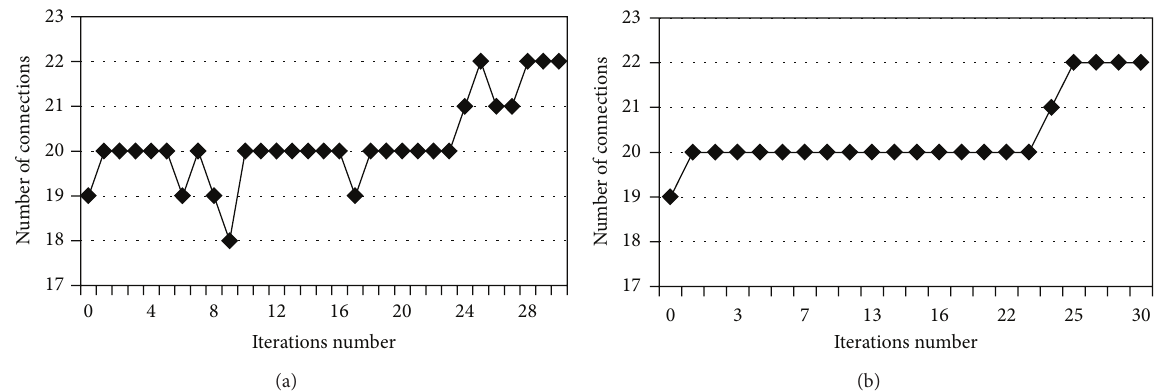
Figure 5: (a) Number of connections at all iterations. (b) Number of connections among acceptable moves.